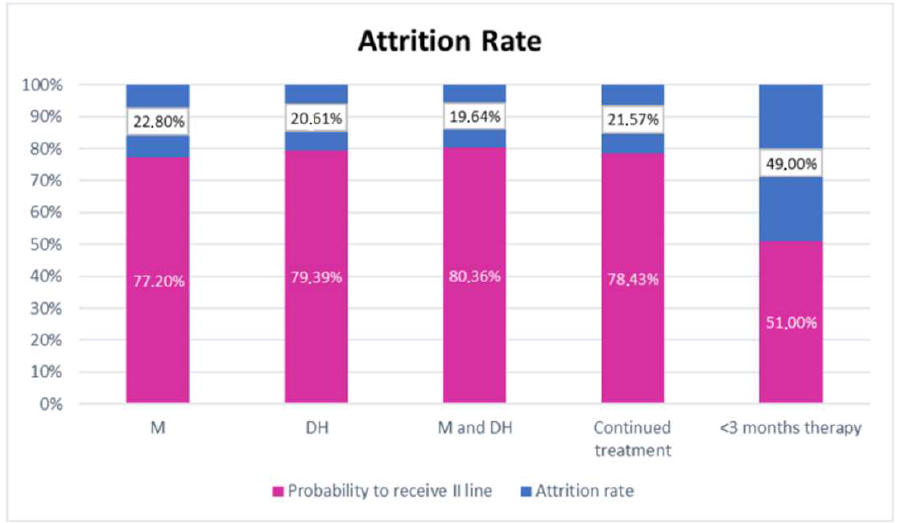
Figure 3. Attrition rate and probability of receiving II line treatment. M: maintenance; DH: drug holidays; M and DH: maintenance and drug